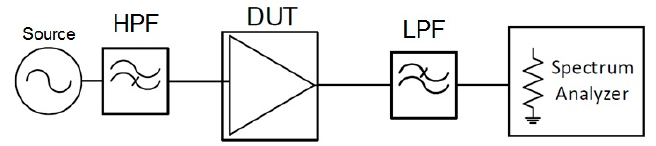
Figure 3. Measuring the second harmonic output of an amplifier using an ideal linear source.